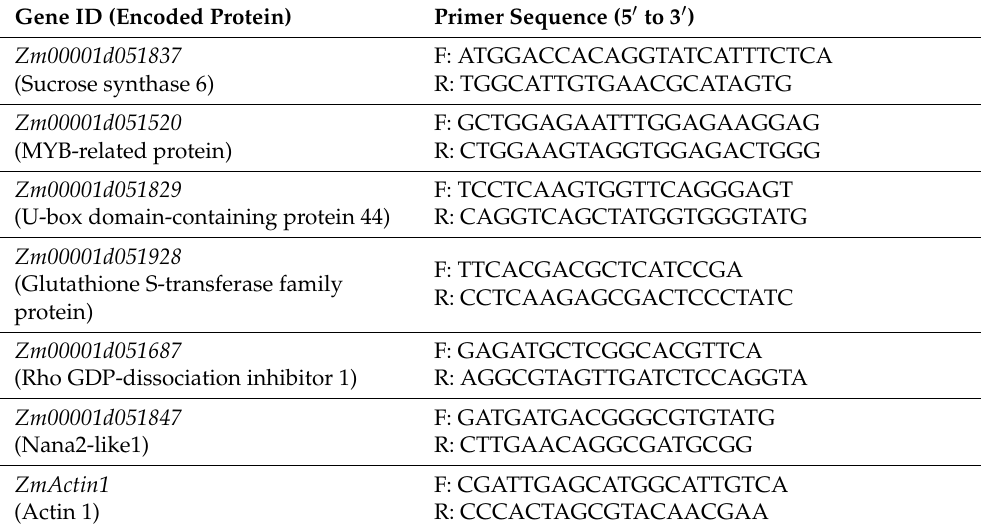
Table 3. Sequences of primers from six candidate genes used in